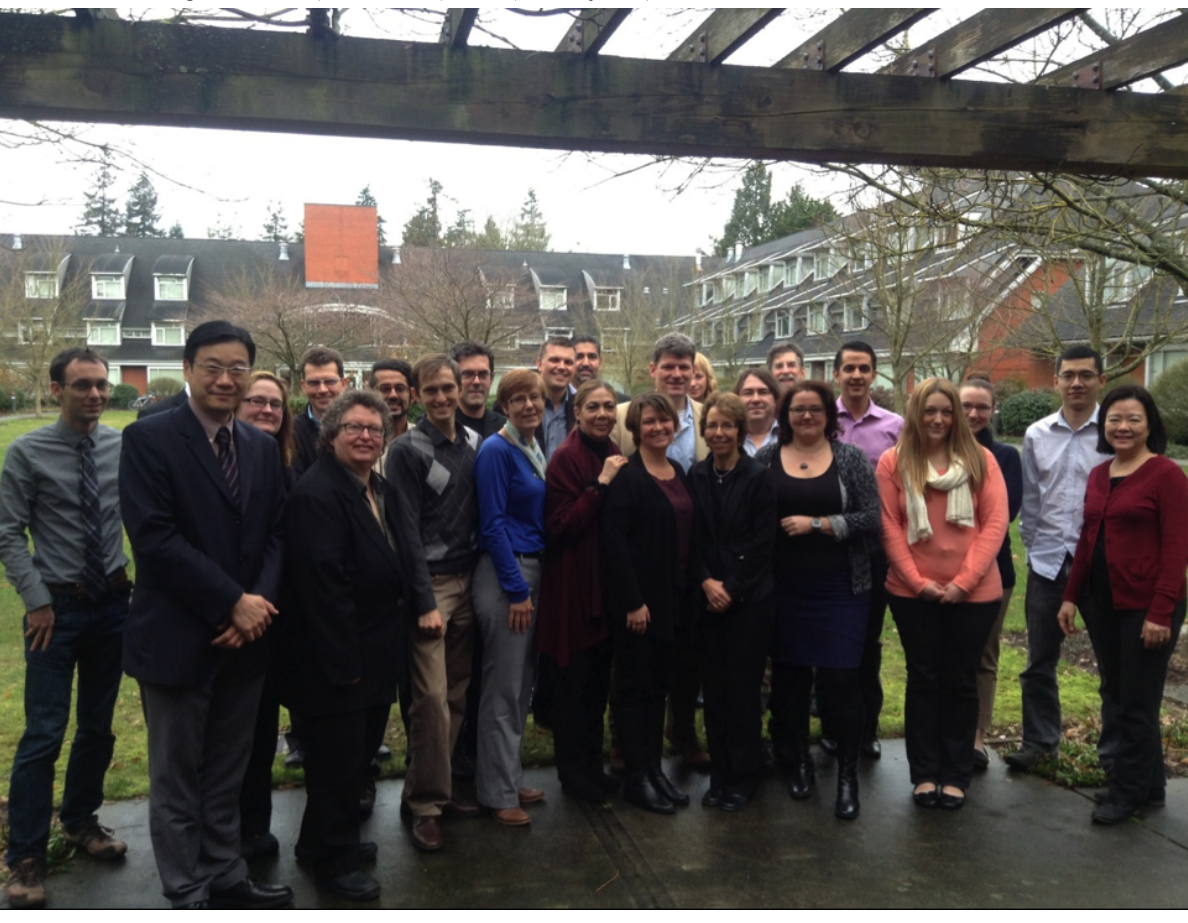
Figure 1. Participants of the Peter Wall Institute of Advanced Studies funded workshop "Harnessing the Social Web for Health and Wellness: Issues for Research and Knowledge Translation", in Vancouver, Canada, February 3 - 5,